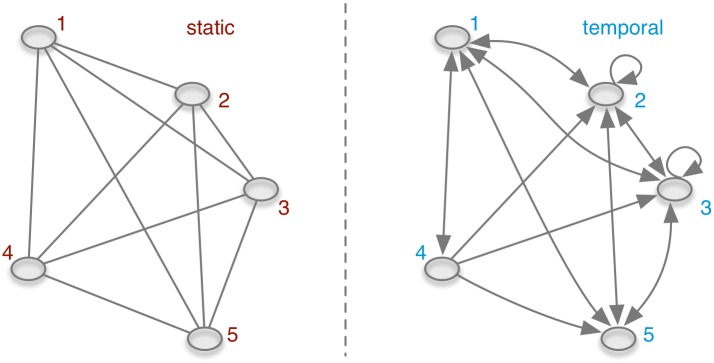
Accessibility graphs of the network of Fig 8.All nodes in the static accessibility graph (left) have a path back to themselves (i.e. self-loops, not shown). Note that although the underlying temporal network is undirected, the temporal accessibility graph is directed.